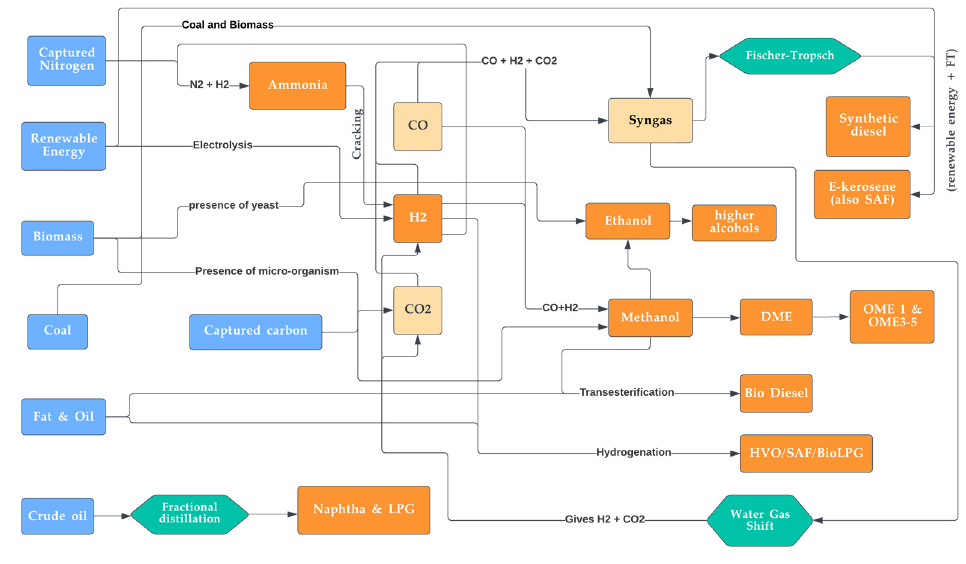
Figure 20. Overview of combined routes for the synthesis of various major synthetic fuels.